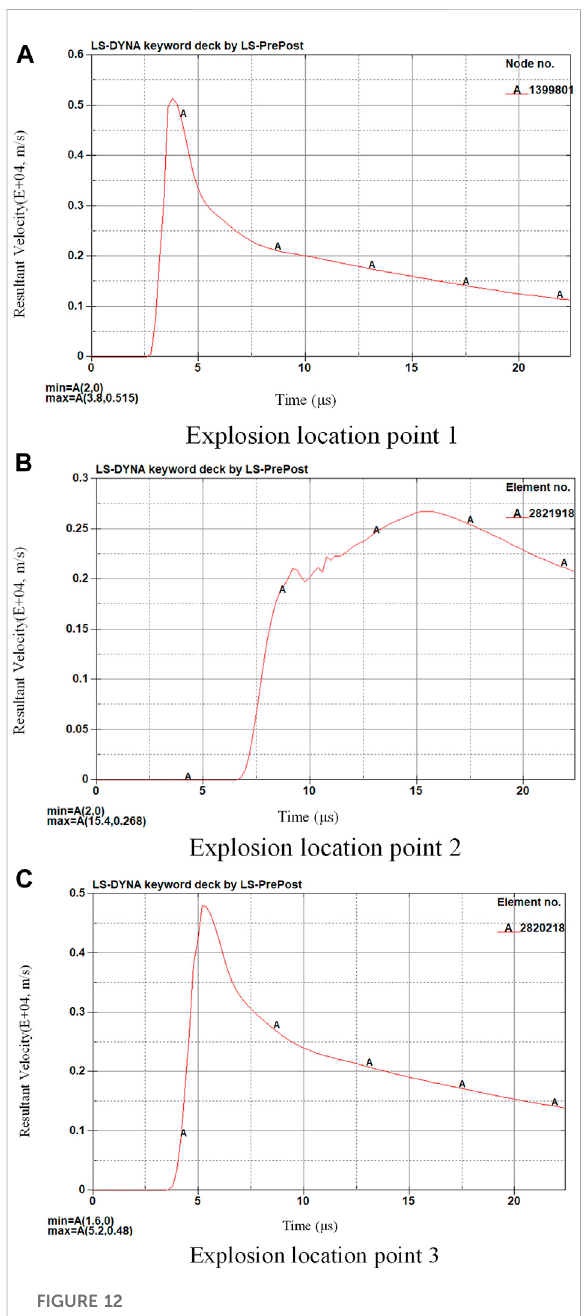
FIGURE 12 Total speed of measuring points in front of the UAV fuel